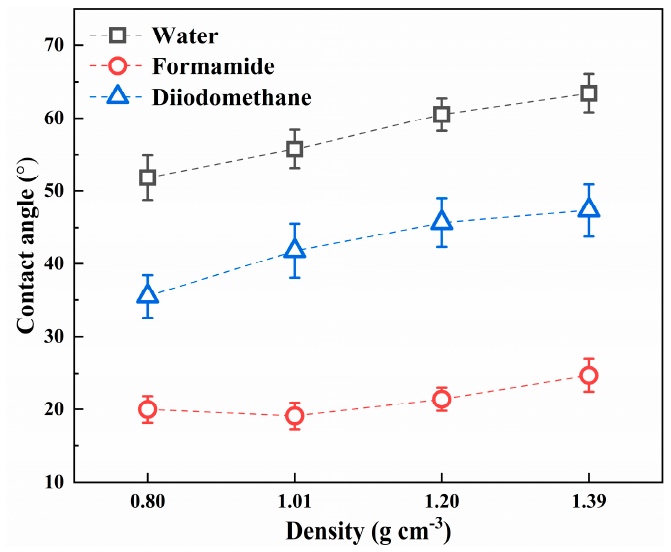
Figure 1. Contact angles of water as a function of time for scrimbers with various densities.